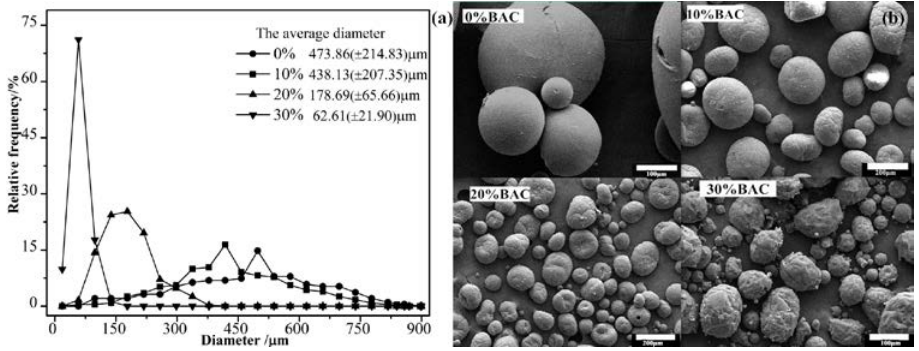
Figure 4. The diameter ( a ) and surface morphology ( b ) of microcapsules obtained at various solvent.